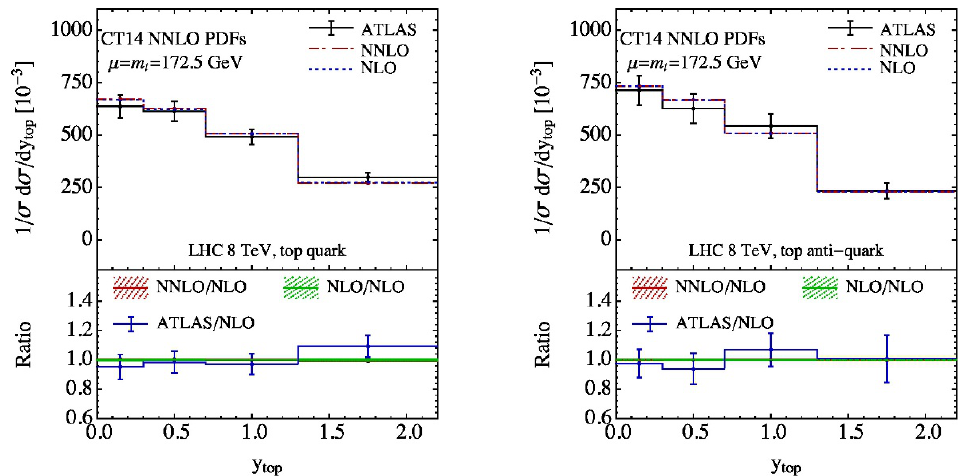
Figure 24 . Predicted rapidity distribution of the top (anti-)quark from t -channel single top-quark production at 8 TeV compared with the ATLAS